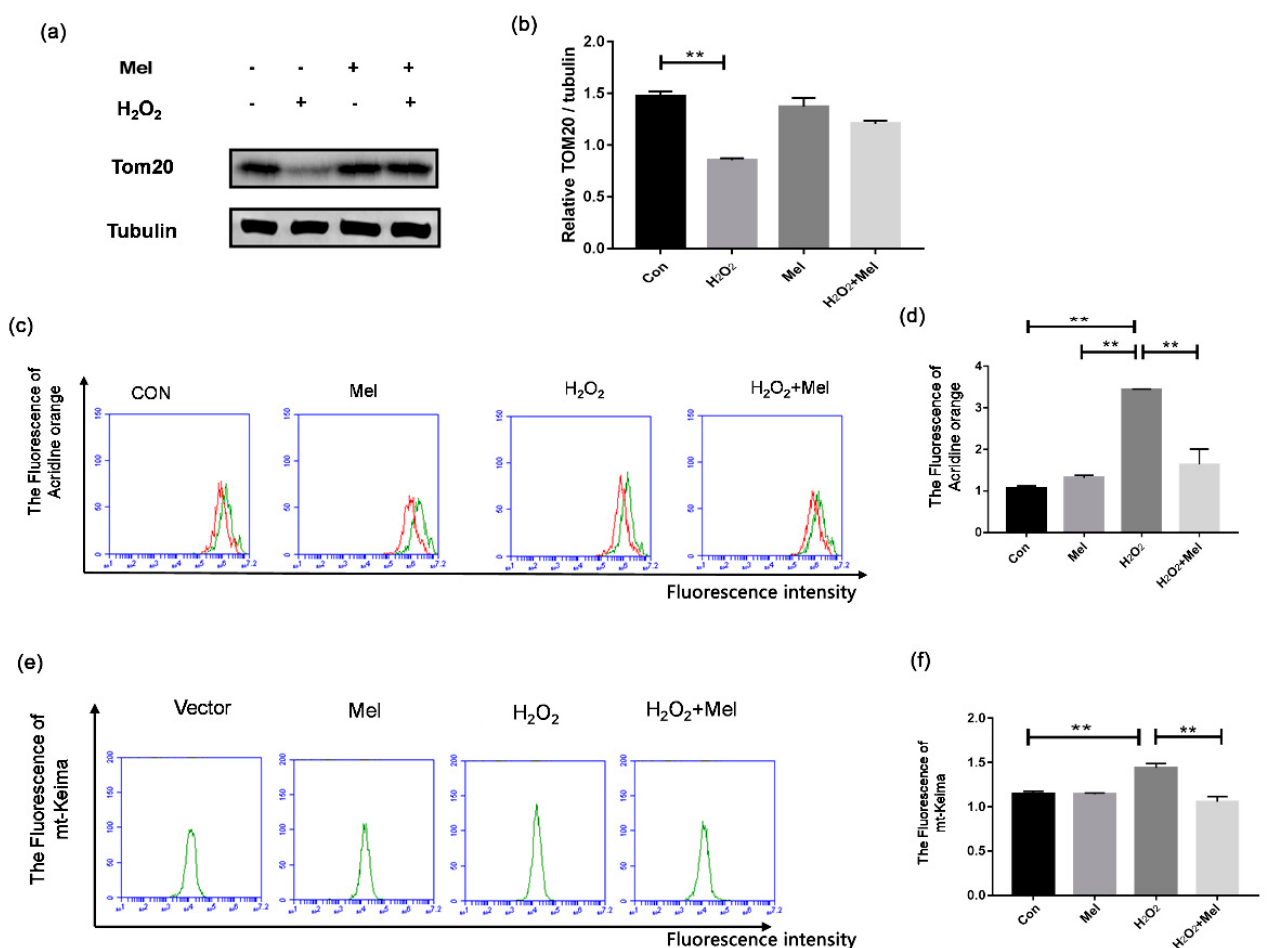
Figure 4. MEL suppressed oxidative stress-induced mitophagy in GCs. ( a , b ) GCs incubated with or without 200 μ M H 2 O 2 for 1 h were then treated with MEL for another 2 h. The protein expression of Tom20 was determined by Western blotting and α -tubulin served as the control for loading. ( c , d ) GCs were exposed to 200 μ M H 2 O 2 for 1 h, and then treated with 10 μ M MEL for 2 h. The acridine orange staining was performed to detect acidic autophagic vacuoles. ( e , f ) GCs were transfected with pMT-mKeima-Red after exposure to 200 μ M H 2 O 2 for 1 h, and then treated with 10 μ M MEL for 2 h. Then, the cells were washed twice with PBS and detected by FCM analysis. The +Y axis is 100 times the number of cells, and the +X axis is the intensity of cell fluorescence. Experiments were repeated in triplicate. Data represent mean ± S.E; n = 3. Significances were marked as ** p < 0.01 vs. control group.